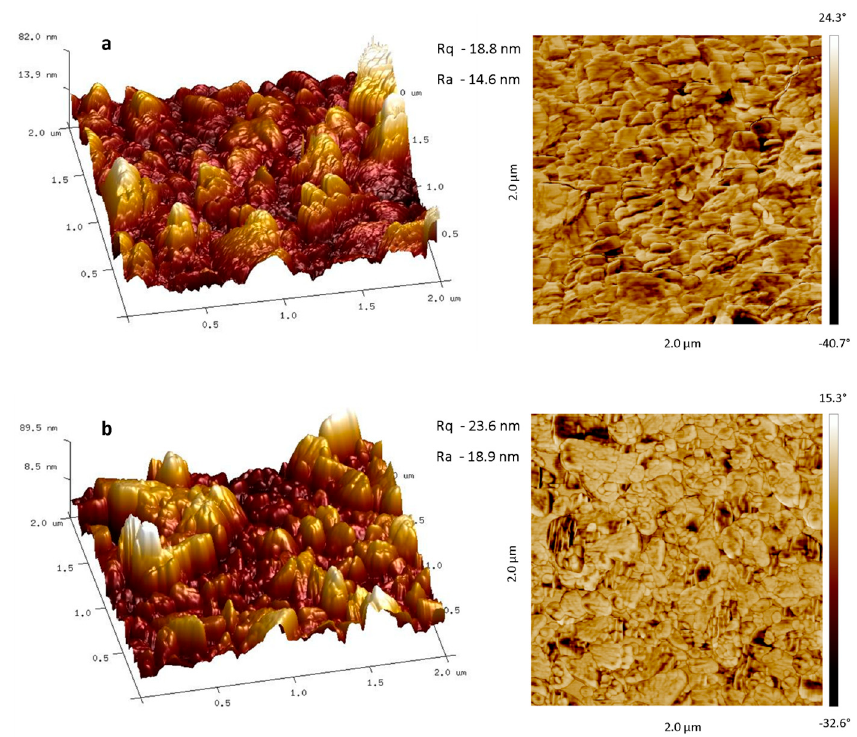
Figure 13. AFM images of 0.3% (w / v) Zn-Carb thin film deposited by dip-coating using the following parameters: ( a ) speed: 20 mm / min, reps: 60; ( b ) speed: 10 mm / min, reps: 60.